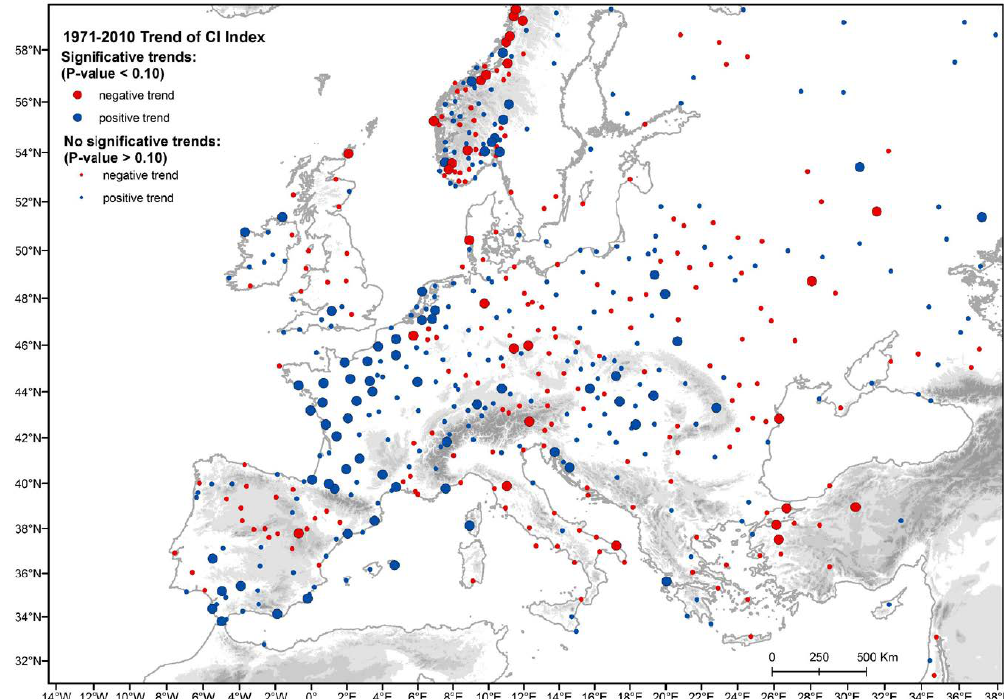
Fig. 10. Spring CI trend distribution (1971–2010). Positive trends are in blue and negative ones in red. Large dots represent significative trends ( p < 0 . 10), otherwise small dots are